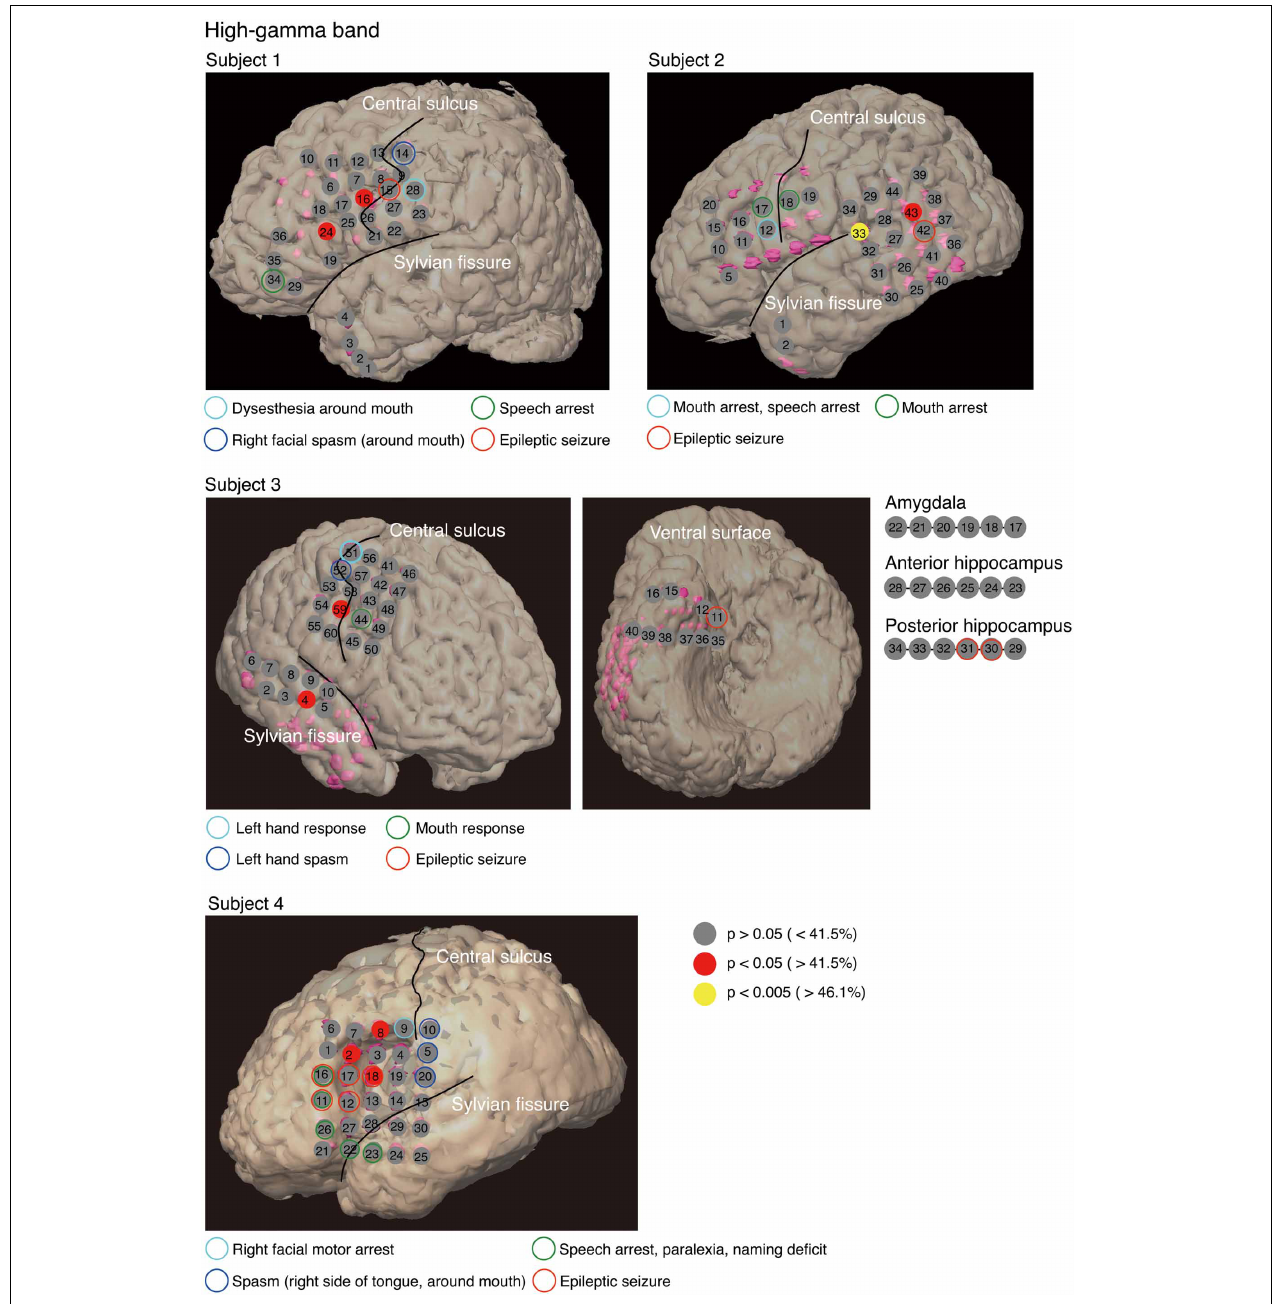
FIGURE 4 | Decoding accuracies acquired from the high-gamma power spectra for each electrode in individual subjects. We estimated the decoding accuracy of each electrode by 15-fold cross-validation. Decoding accuracies were superimposed onto the electrode map of each subject. To facilitate visualization, for Subject 3, electrodes 17–34 are not superimposed